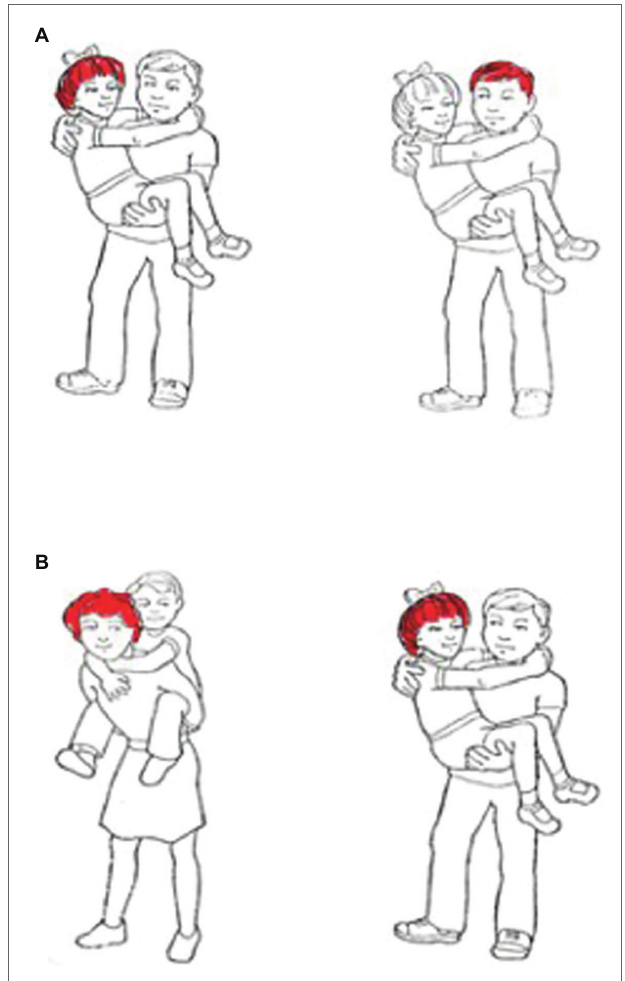
FIGURE 3 | Each sentence in the relative clause sentence comprehension task was presented twice, each time with a different set of picture choices. For example, “The girl that the boy carried had red hair” was presented with a picture set in which the incorrect picture portrayed the correct action clause but the incorrect descriptive clause (A) and a set in which the incorrect picture portrayed the correct descriptive clause but the reversed action clause (B)